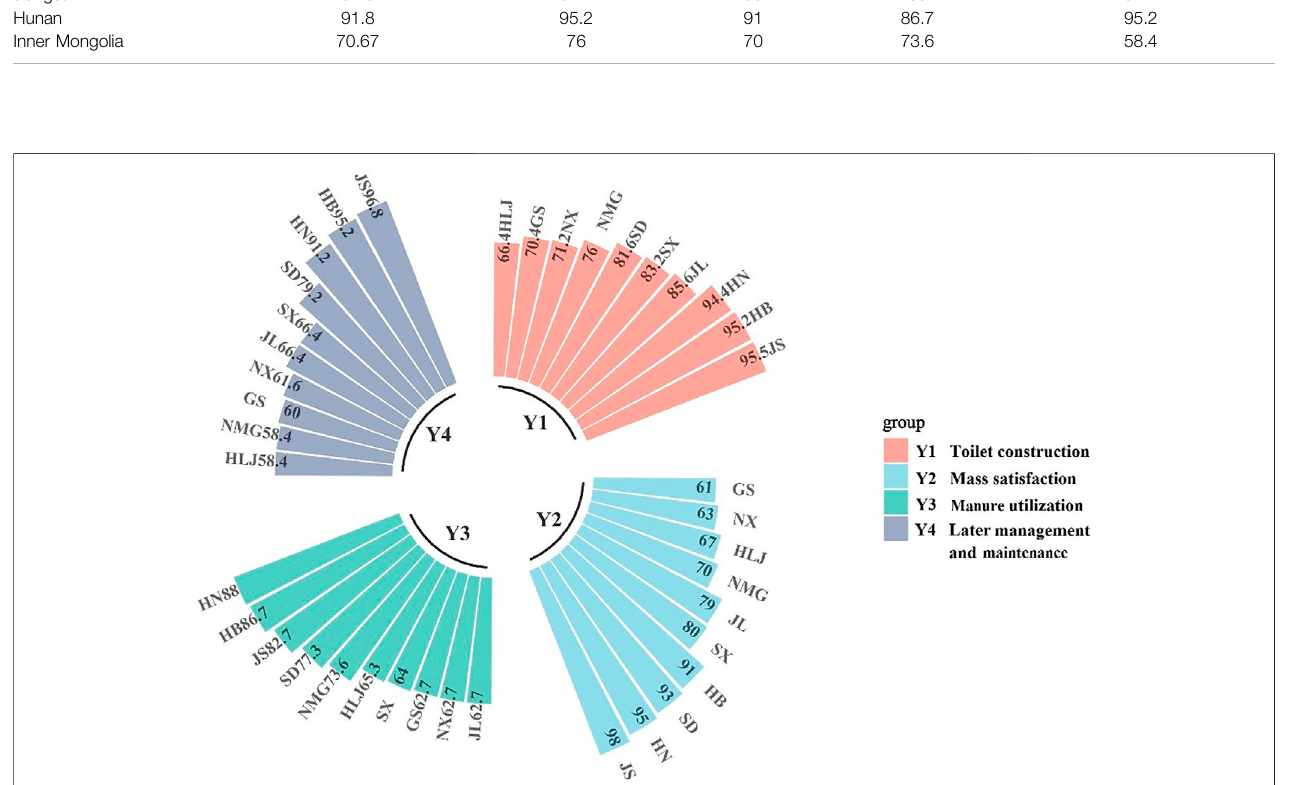
Frontiers in Environmental Science |